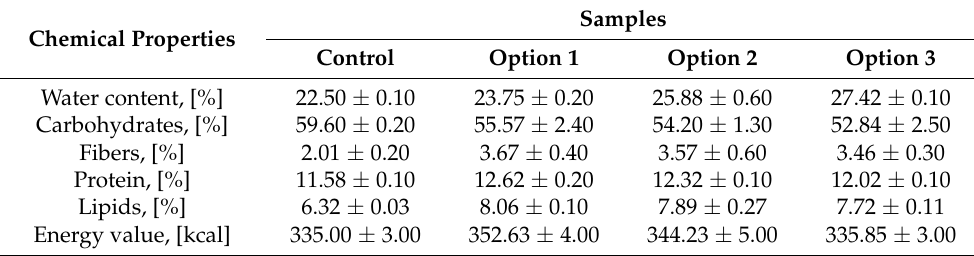
Table 5. Physicochemical characteristics of sponge cake without and with dried Sambucus nigra L. blossom.